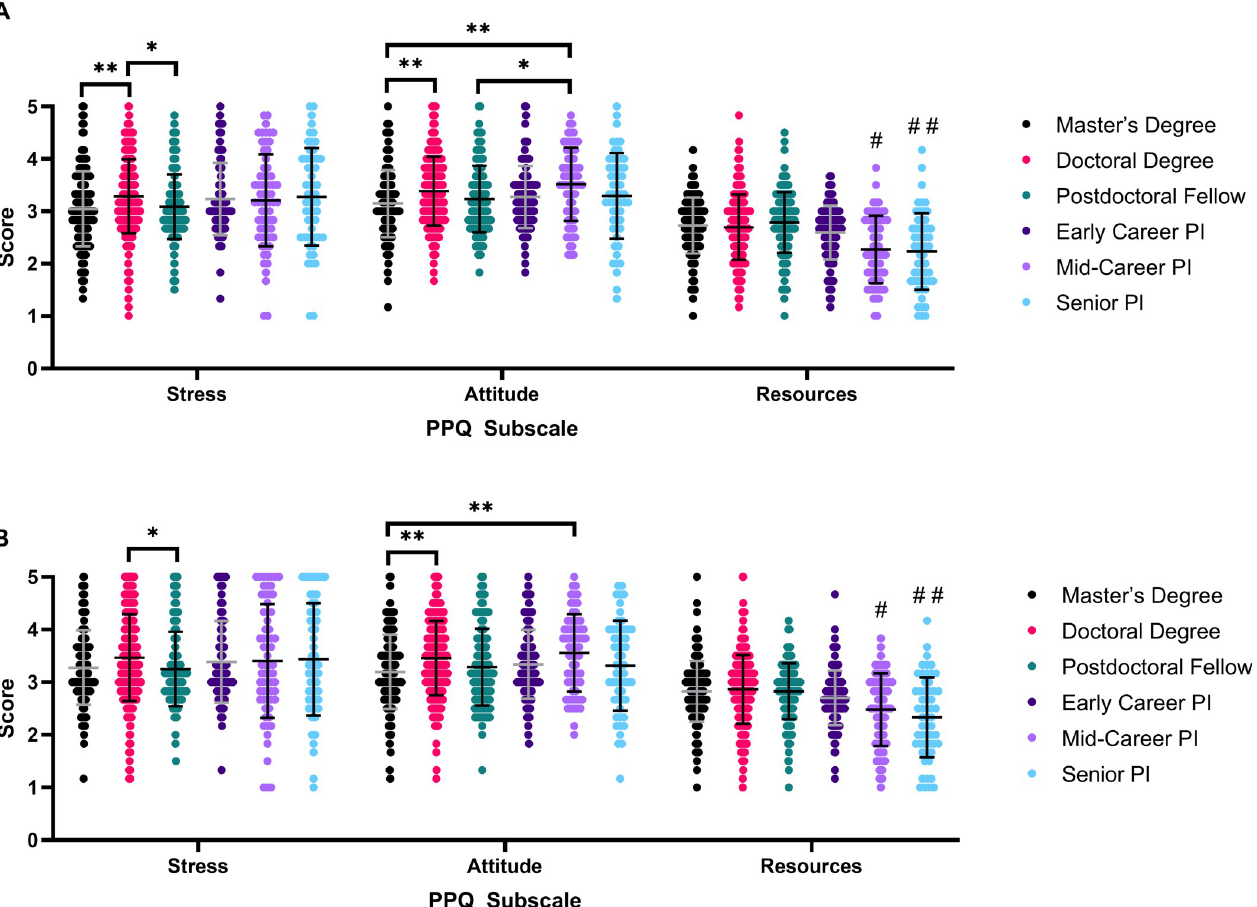
Fig 2. Differences in publication pressure questionnaire subscale scores between academic positions. N = 1020, one-way ANOVA analysis. � P � 0.05, �� P � 0.01, ��� P � 0.001, ���� P � 0.0001. PI: Principal Investigator. (A) Scores Pre-COVID. # = significant difference between Mid-Career PI with Master’s Degree, Doctoral Degree, and Postdoctoral Fellow ( ���� ). Significant difference between Mid-Career PI with Early Career PI ( �� ). ## = significant difference between Senior PI with Master’s Degree, Doctoral Degree, and Postdoctoral Fellow ( ���� ). Significant difference between Senior PI with Early Career PI ( �� ). (B) Scores Post-COVID. # = significant difference between Mid-Career PI with Master’s Degree ( �� ), Doctoral Degree ( ���� ), and Postdoctoral Fellow ( ��� ). ## = significant difference between Senior PI with Master’s Degree, Doctoral Degree, and Postdoctoral Fellow ( ���� ). Significant difference between Senior PI with Early Career PI ( ��